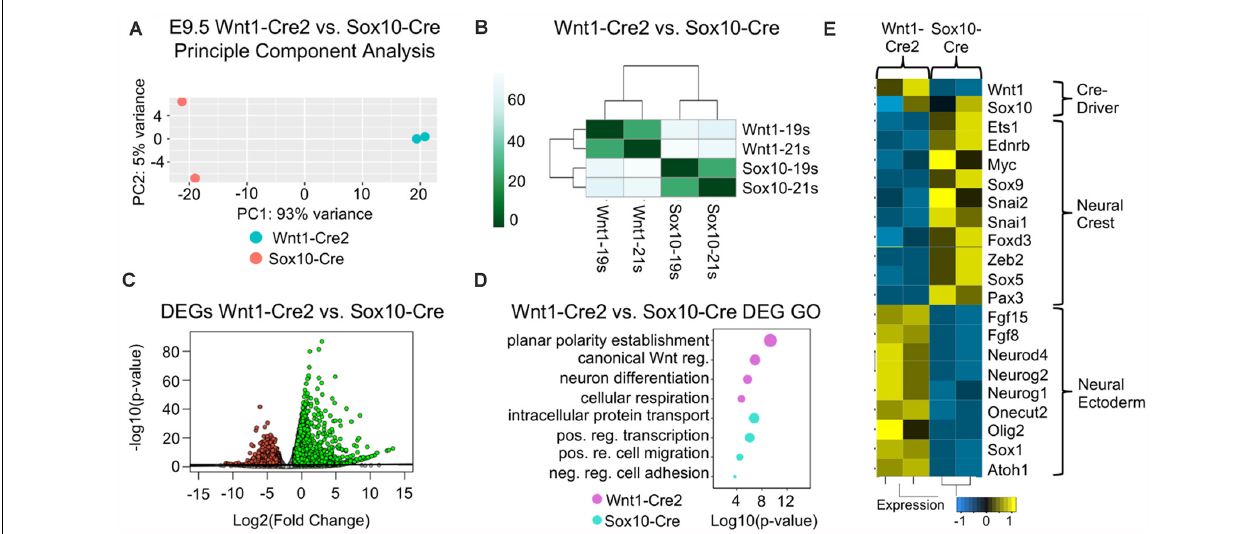
FIGURE 2 | Cells harvested using Wnt1-Cre2 have a neuroepithelial gene signature compared to cells harvested using Sox10-Cre. (A) Principal component analysis (PCA) plot and (B) heatmap normalized counts per million reads (CPM) showing that samples group together by Cre-driver. (C) Volcano plot of the significantly up- and downregulated genes obtained from comparing Wnt1-Cre2 to Sox10-Cre. (D) Gene ontology (GO) analysis of the significant differentially expressed genes. Categories were ordered by − log10( p -value) and dot size represents − log10( p -value). (E) Heatmap of normalized CPM values for neural crest and neuronal genes from cells harvested with Wnt1-Cre2 or Sox10-Cre.